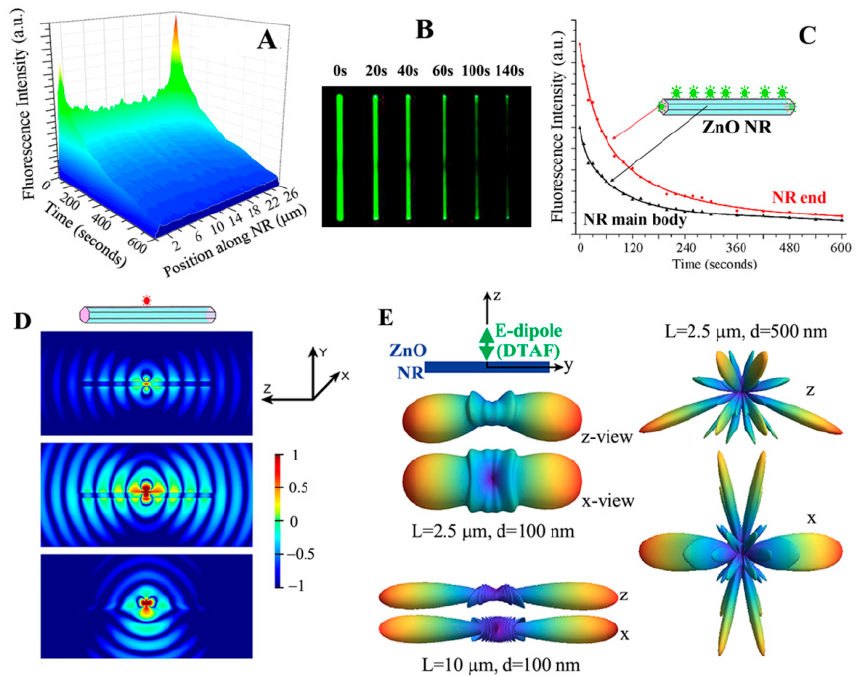
Figure 7. Spatially localized, temporally extended biomolecular fluorescence signal observed on individual ZnO NRs. ( A , B ) The contour map in ( A ) and the time-lapse images in ( B ) display the fluorescence intensities of fluorophore-linked IgG antibodies, DTAF-antiIgG, measured along the long axis of a 25 μ m -long ZnO NR; ( C ) Differences in the time-dependent decay profile of the fluorescence intensity were clearly observed depending on the ZnO NR crystal facets. Red and black data show biomolecular fluorescence measured from the NR end and main body, respectively; ( D ) FDTD simulations were carried out to obtain the radiation patterns from a single emitter radiating at 576 nm placed 10 nm from the ZnO NR surface, with the dipole oscillation polarized along the X -(top), Y -(middle), and Z -(bottom) direction; ( E ) The dimensional effect of ZnO NRs on FINE was evaluated by simulating far-field radiation patterns of a 517 nm electric dipole. A pair of far-field patterns is shown for each NR of the specified length (L) and width (d) where the top/bottom simulation corresponds to the spatial patterns observed from the Z -/ X -axis. Reproduced with permission from Ref. [85] Copyright (2014) Royal Society of Chemistry.